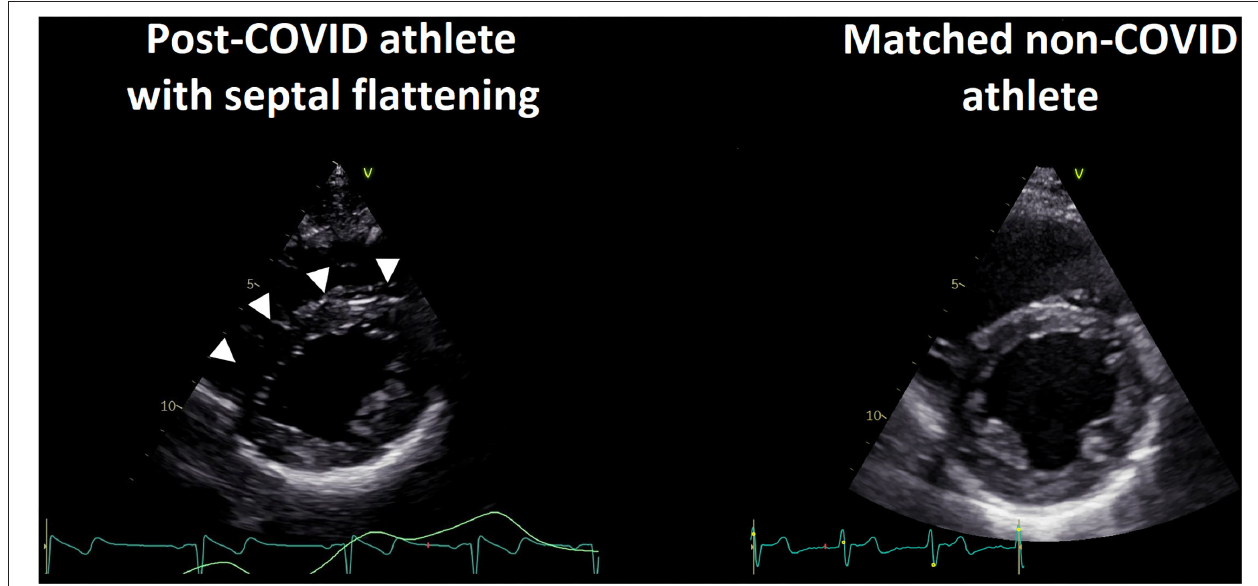
FIGURE 1 | Representative case of the post-COVID septal flattening (SF) in athletes. Parasternal short-axis views at the level of the papillary muscles at mid-diastole in a young athlete underwent asymptomatic SARS-CoV-2 infection and his matched control. In the post-COVID athlete, a prominent SF can be seen with early diastolic dominance and inspiratory enhancement (left, SF shown by arrows), compared to the propensity score-matched control (right).